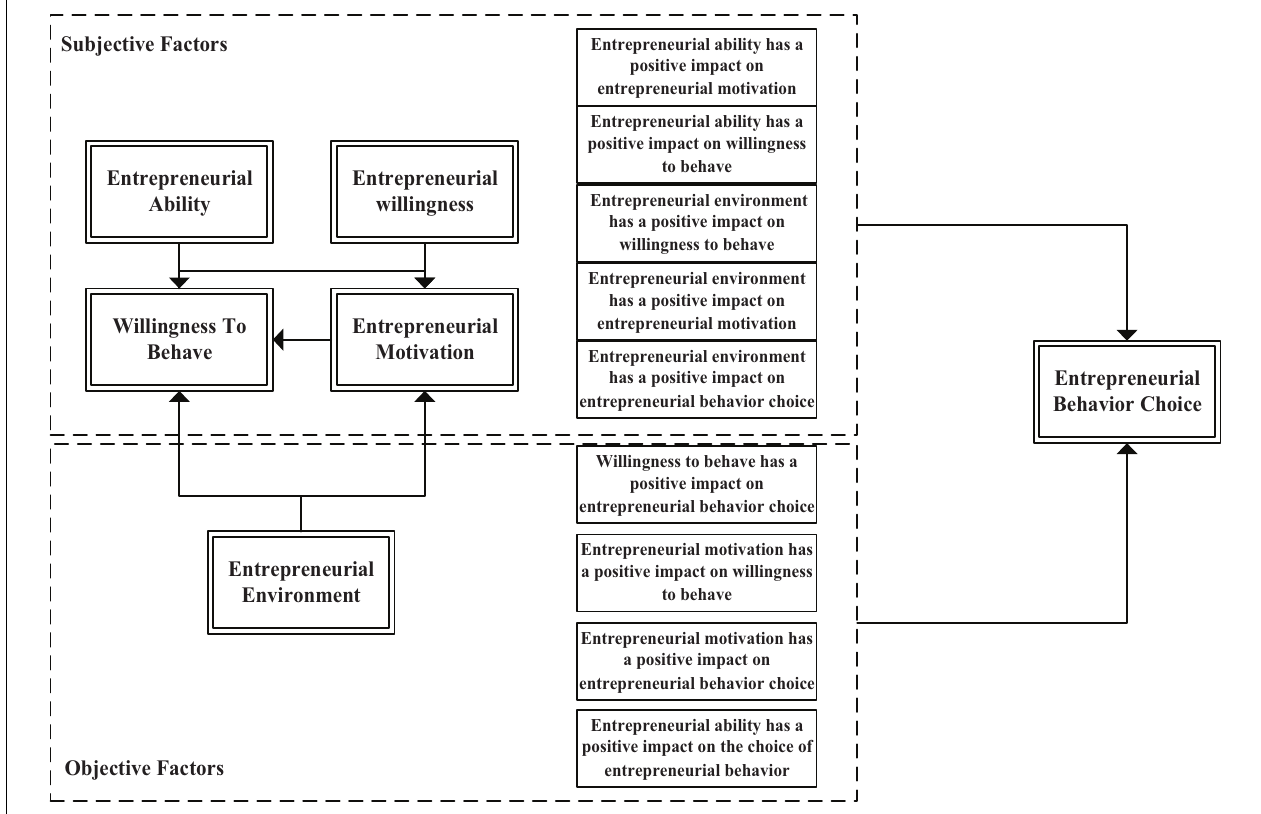
FIGURE 7 | The influencing factor model of the entrepreneurial behavior